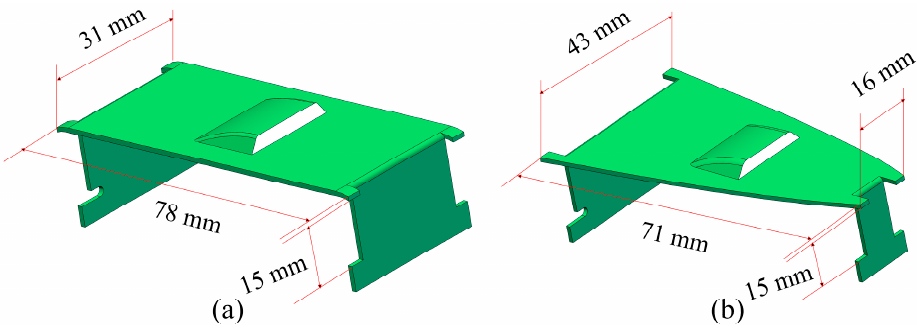
Figure 2. Valve structures: ( a ) rectangular guided valve; ( b ) parabolic–shaped guided valve.